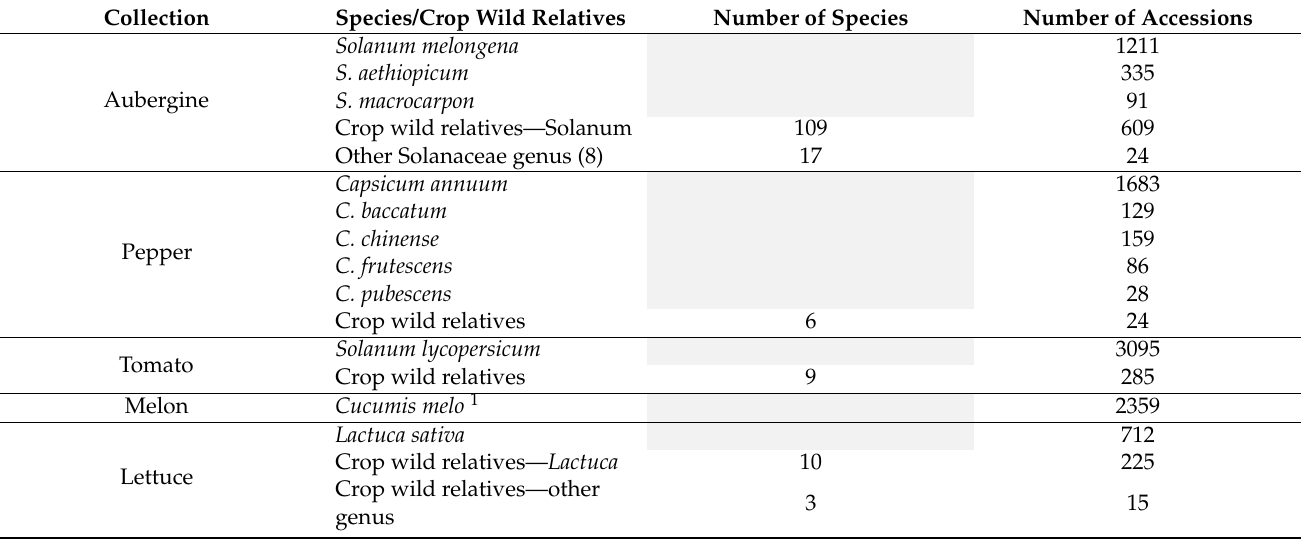
Table 2. Summary of taxonomy of the collections for the accessions whose taxonomy has been